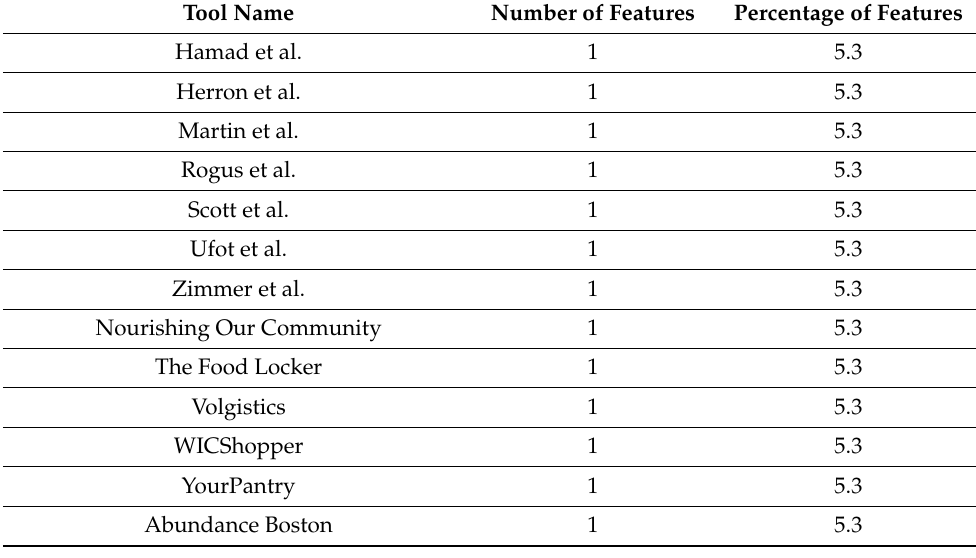
Table 5. Number of tools per